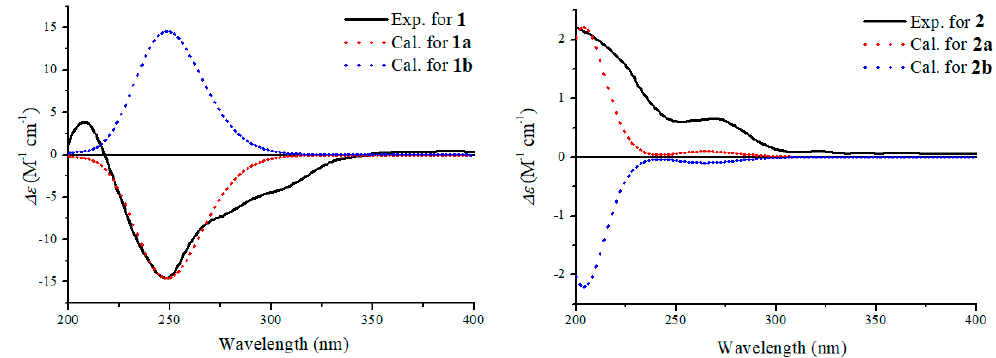
Figure 8. Experimental electronic circular dichroism (ECD) spectrum of 1 – 2 in MeOH and the calculated circular dichroism (CD) spectra of 1a – 2a and 1b – 2b .